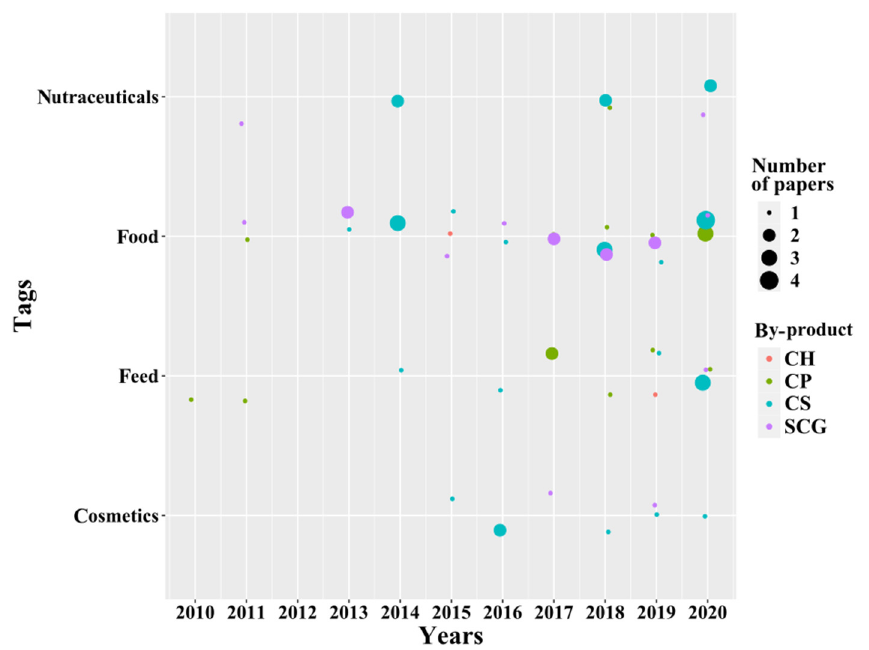
Figure 7. Temporal analysis of bioactive compound applications.